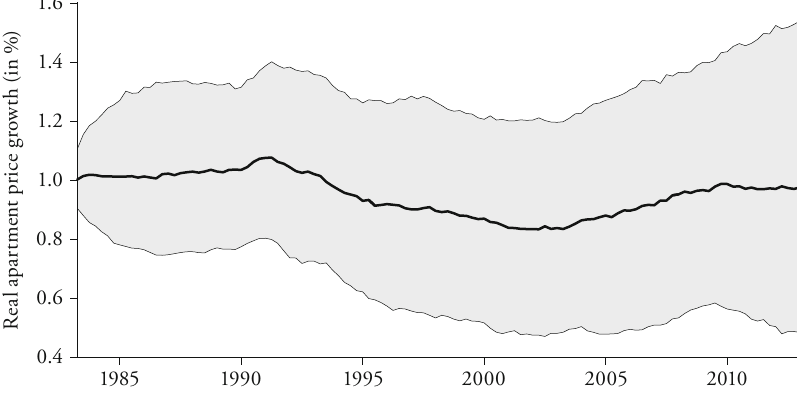
Figure 12: Peak Effect (after 5 Quarters) of Apartment Price Responses to a Shock on the Mortgage Rate Change (i. e. User